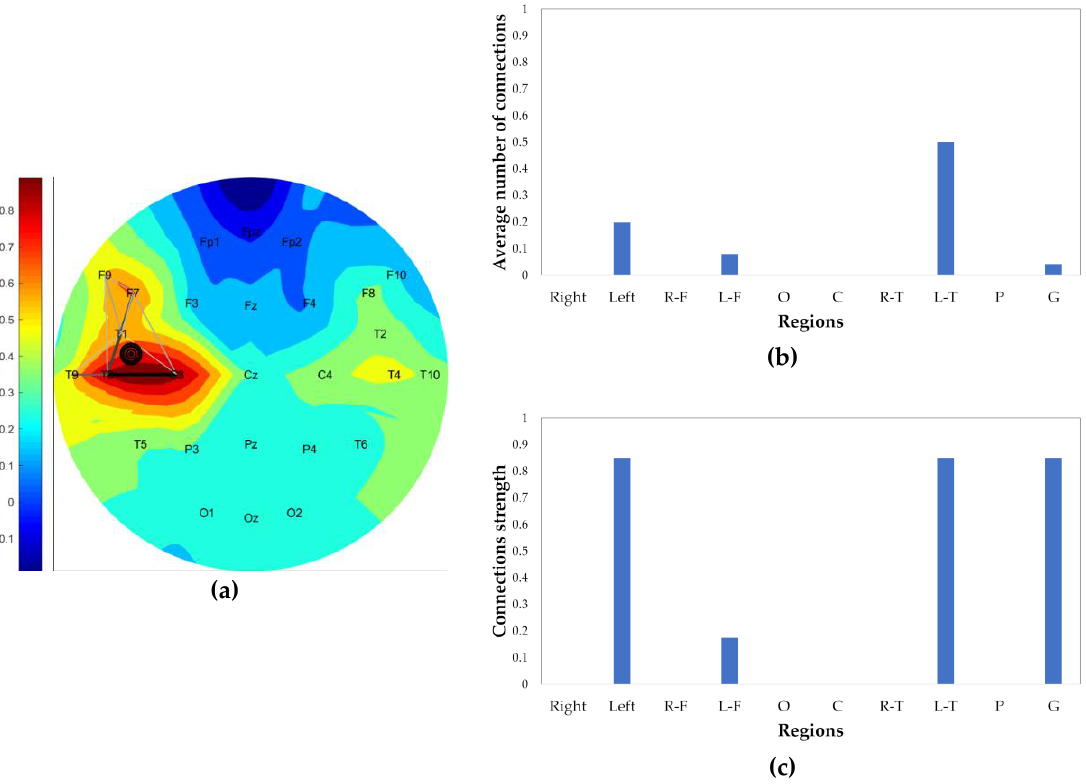
Figure 4. Correlation within the network (CN) example at the beginning of a seizure; ( a ) CN contains connection, marked target of the seizure origin, and colored-background by the normalized power of the channels; ( b ) average number of connections in each region (right, left, right-frontal (R-F), left-frontal (L-F), occipital, central, right-temporal (R-T), left-temporal (L-T), parietal, general); and ( c ) strength of connection in each region.